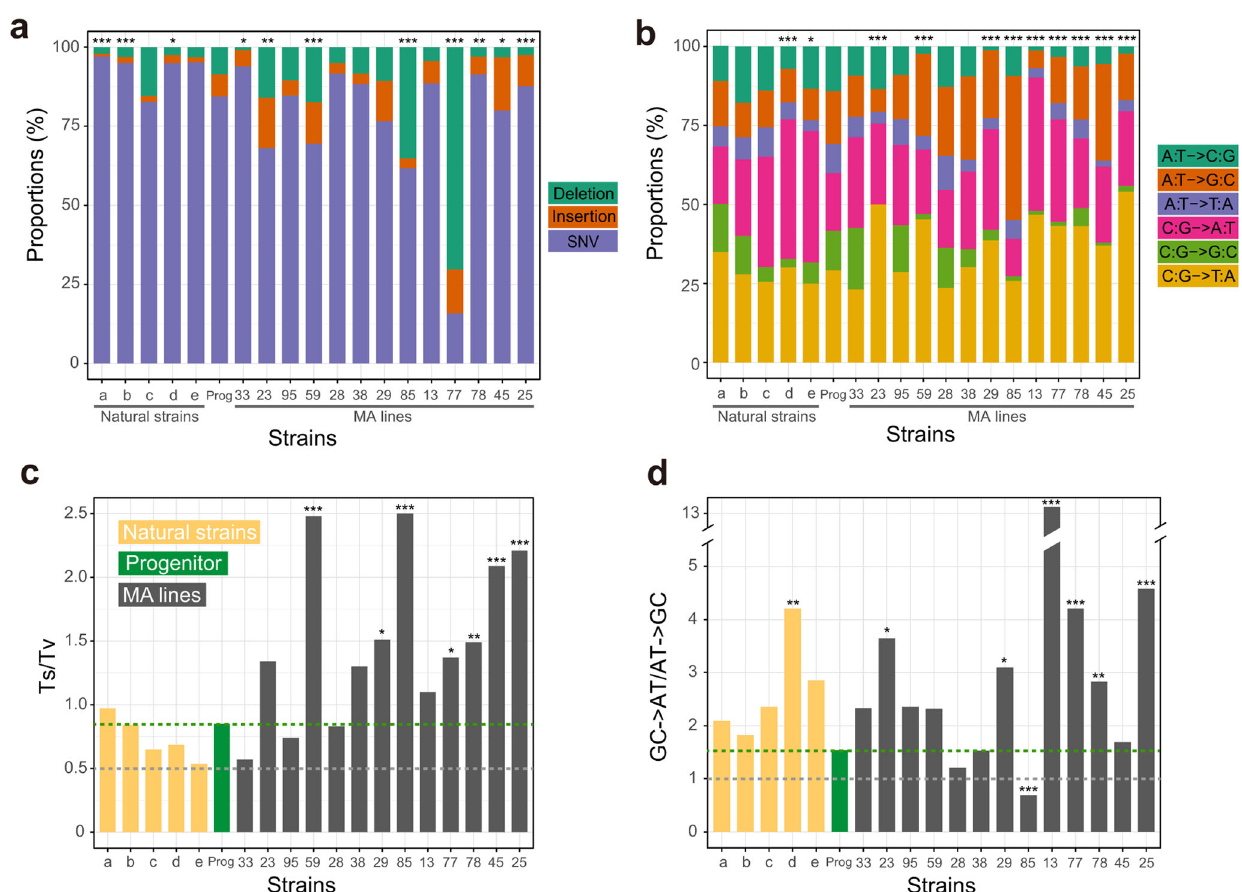
“ Fig. 4 Molecular spectra of mutations in 13 MA lines and 5 naturalyeaststrainsestimatedbyMA+WGS.a ProportionsofSNVs, insertions, and deletions among all mutations. b Relative proportions of the six types of SNVs. c Number of transition mutations relative to the number of transversion mutations (Ts/Tv). d Number of GC → AT mutations relative to the number of AT → GC mutations. In c and d , the graydotted line showsthe randomexpectation while the green dotted